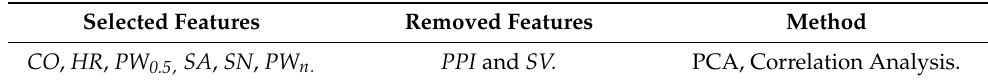
Table 4. Proposed Feature